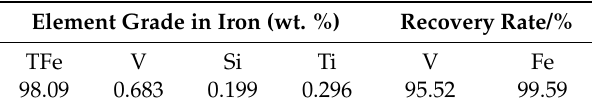
Table 3. Production index of vanadium ‐ bearing iron. Element Grade in Iron (wt. %)